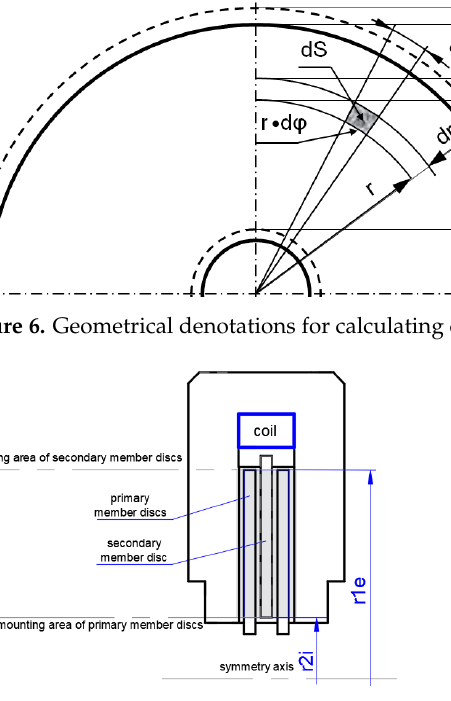
Figure 7. Exact boundaries of the movement region in the example of a magnetorheological clutch with 2 primary member discs (2-disc MR